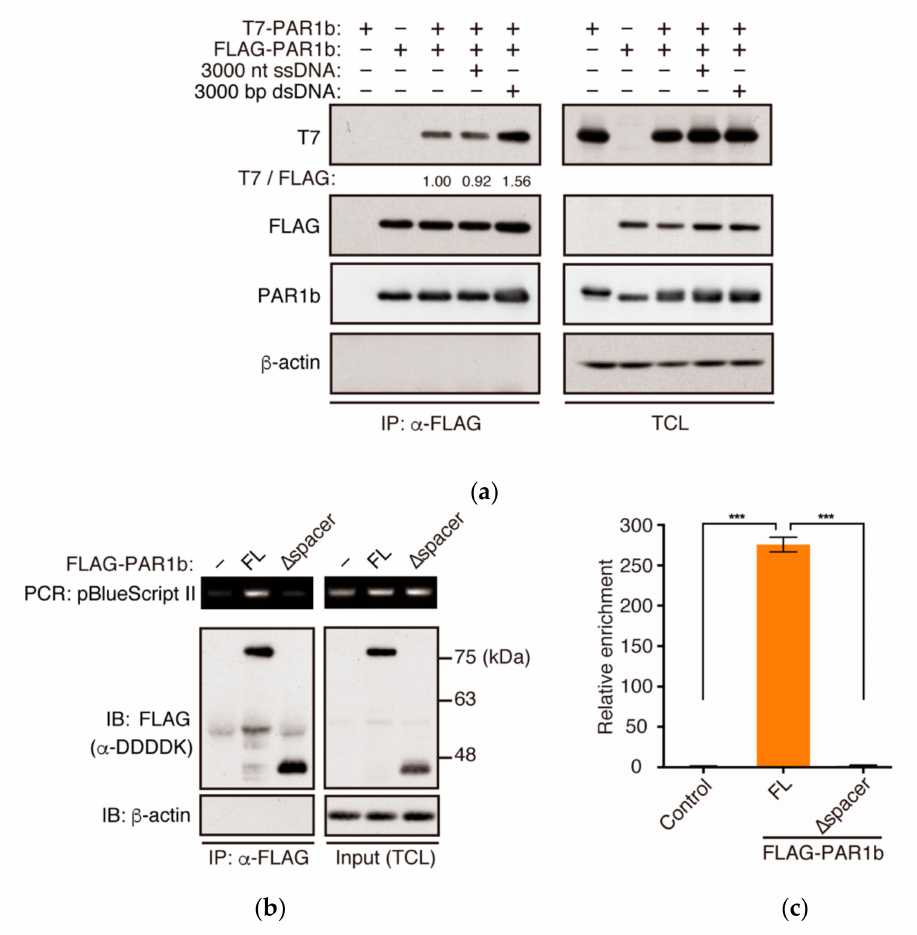
Figure 4. PAR1b can multimerize in a nucleic acid-dependent manner in the cell. ( a ) dsDNA promotes multimerization of PAR1b in cells. AGS cells were transiently transfected with expression vectors for T7-PAR1b and FLAG-PAR1b. After 24 h, cells were transfected with 2 µ g/mL 3000 nt ssDNA or 3000 bp dsDNA for 5 h followed by immunoprecipitation. ( b ) PAR1b can interact with DNA directly through the spacer region in cells. AGS cells were transiently transfected with FLAG-PAR1b expression vectors. After 24 h, cells were transfected with a mixture of pBlueScript II and salmon sperm dsDNA at a ratio of 1:1000 for 2 h before harvest and subsequent DNA-immunoprecipitation. pBlueScript II was detected by PCR using specific primers. ( c ) Quantitative PCR analysis of DNA immunoprecipitants from ( b ). Error bars represent mean ± SD, n = 3. *** p < 0.001, one-way ANOVA, post-hoc Tukey’s